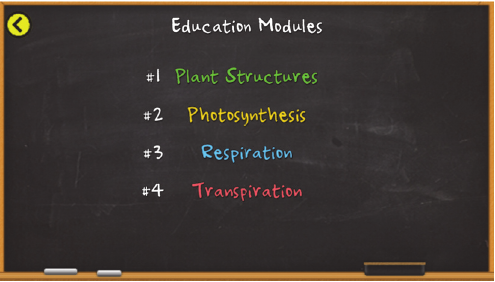
Figure 19: Five development stages of tomatoes.